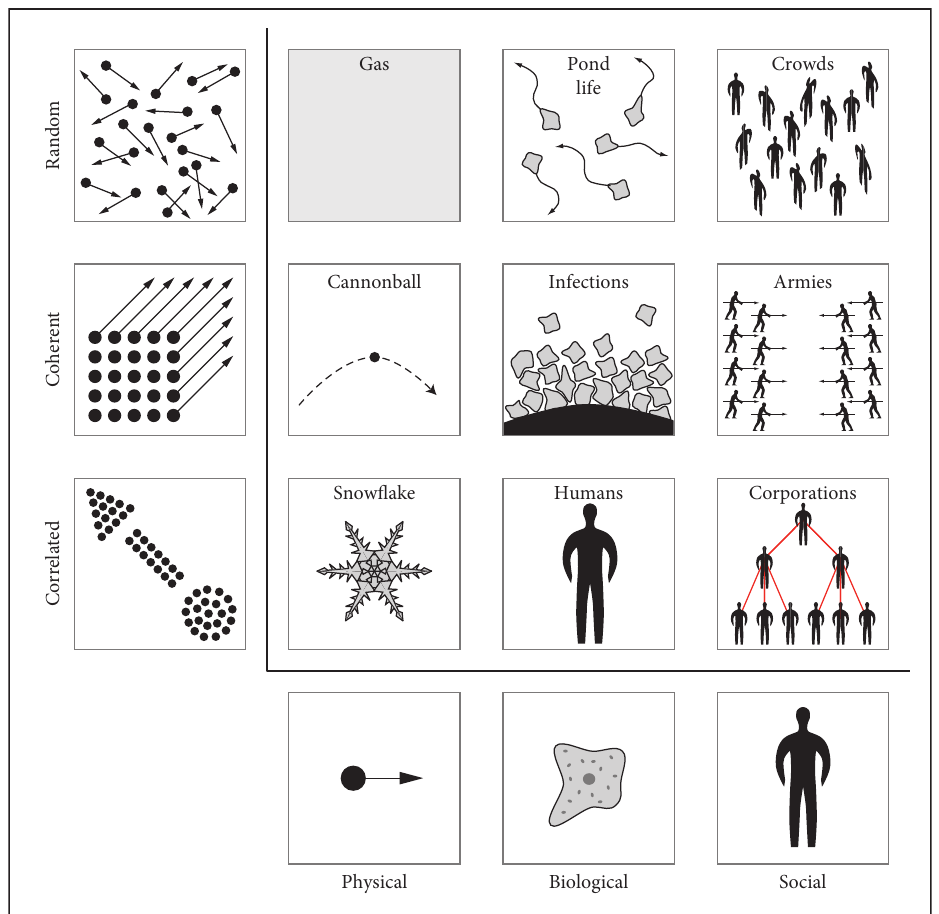
Figure 1: Each column contains three examples of systems consisting of the same components (from left to right: molecules, cells, and people) but with different relations between them. Each row contains systems representing a certain kind of relationship between components. For random systems, the behavior of each component is independent from the behavior of all other components. For coherent systems, all components exhibit the same behavior; for example, the behavior (location, orientation, and velocity) of one part of the cannonball completely determines the behavior of the other parts. Correlated systems lie between these two extremes, such that the behaviors of the system’s components do depend on one another, but not so strongly that every component acts in the same way; for example, the shape of one part of a snowflake is correlated with but does not completely determine the shape of the other parts. Implicit in these descriptions is the necessity of specifying the set of behaviors under consideration, as discussed in Section 2.2. (Image source: